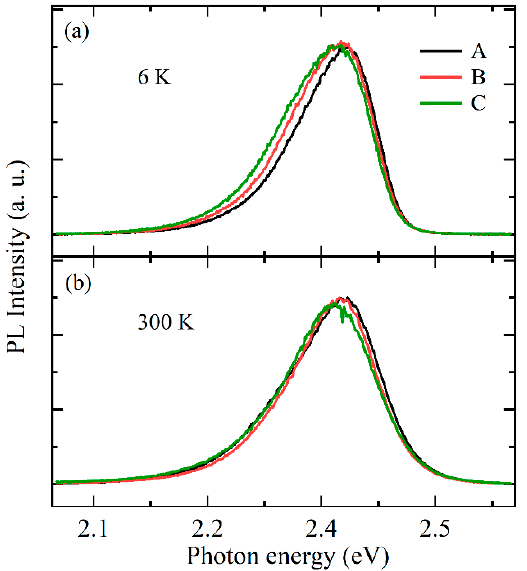
Figure 2. PL spectra of samples A, B, and C measured at 6 K ( a ) and 300 K ( b ).